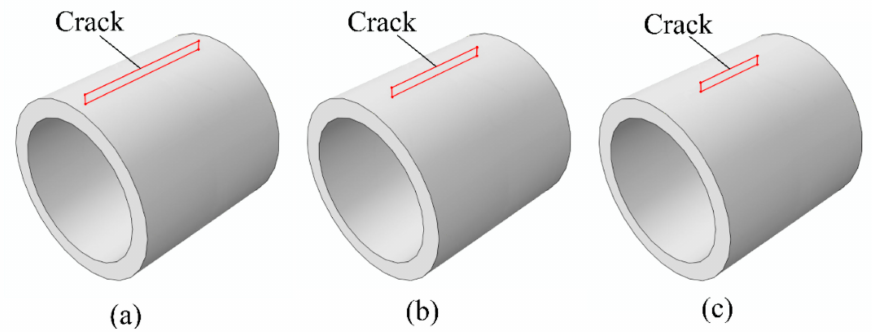
Figure 14. Pipes containing cracks with di ff erent lengths: ( a ) 400 mm, ( b ) 300 mm, and ( c ) 200 mm. (1) Load–strain